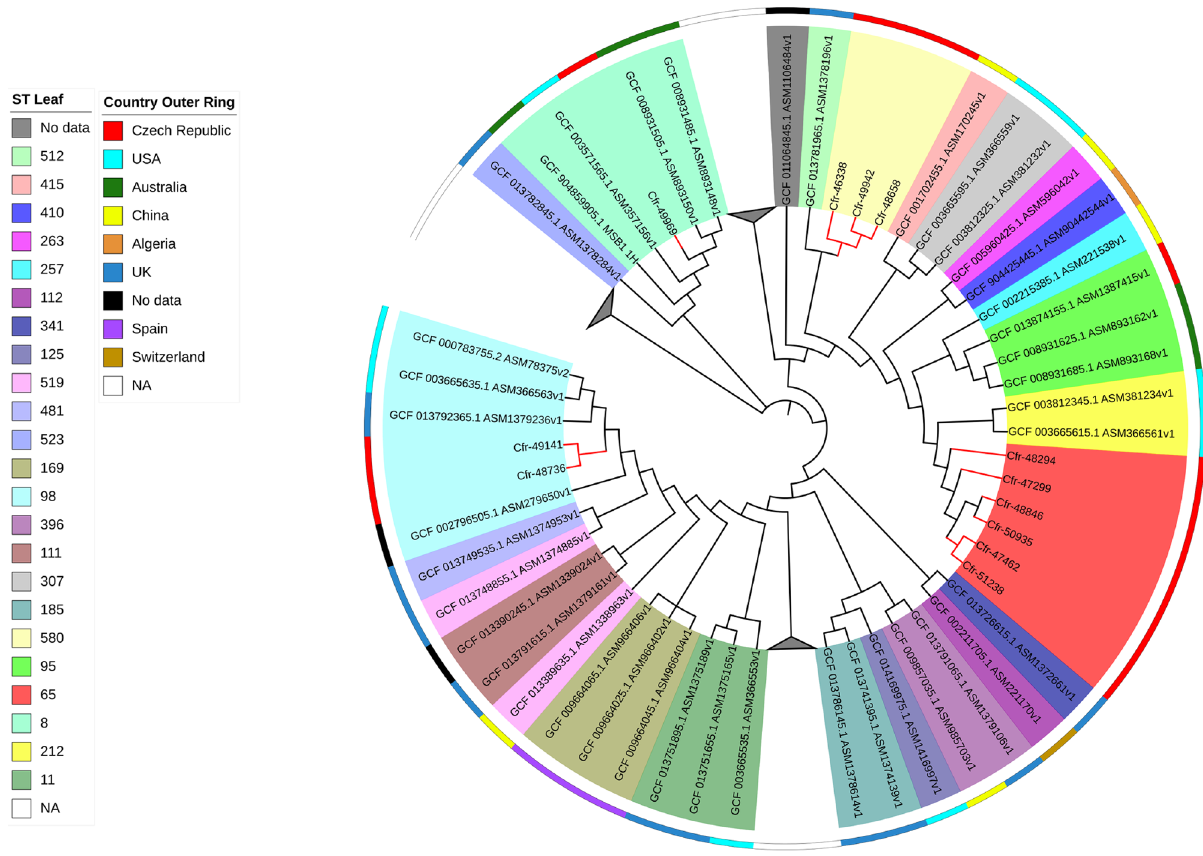
Figure 6. SNPs-based phylogeny of the 12 C. freundii with 118 genomes downloaded from NCBI database. Red nodes indicate the Isolates from the study. Grey triangles indicate collapsed